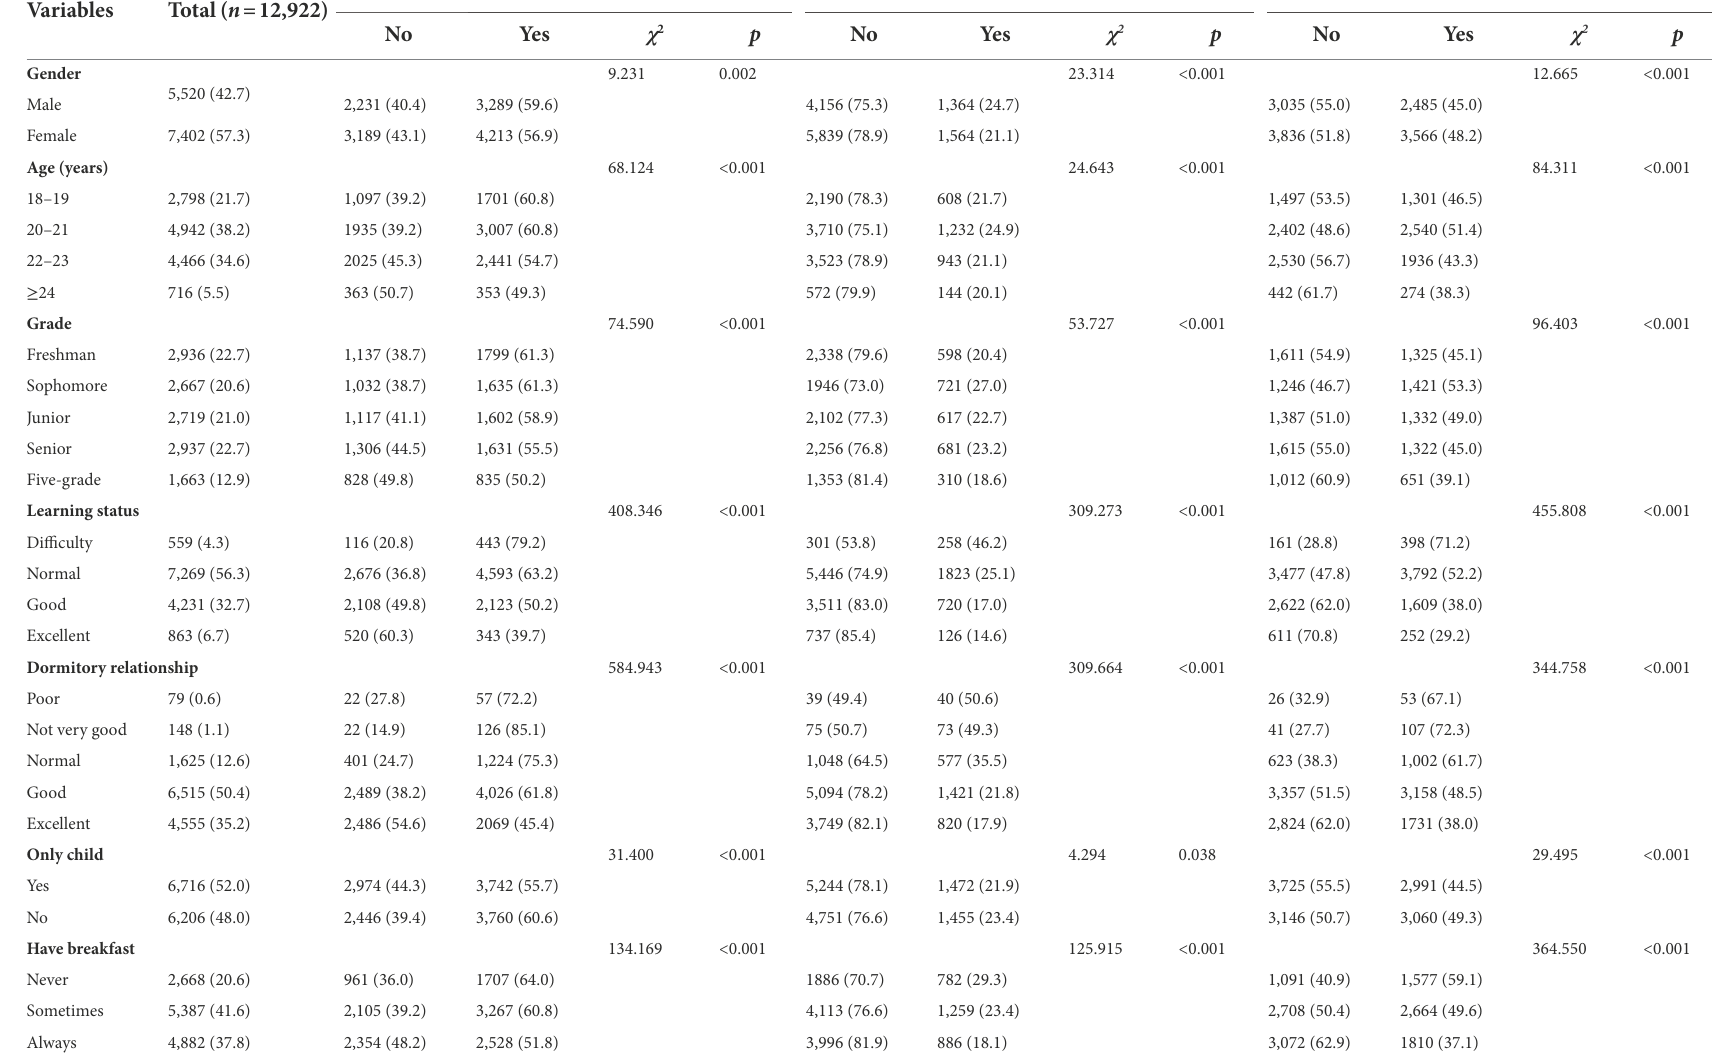
TABLE 2 Comparison of demographic factors and prevalence of interpersonal sensitivity, anxiety symptoms and depression symptoms [ n (%)]. Interpersonal sensitivity Anxiety symptoms Depression Variables Total ( n = 12,922)